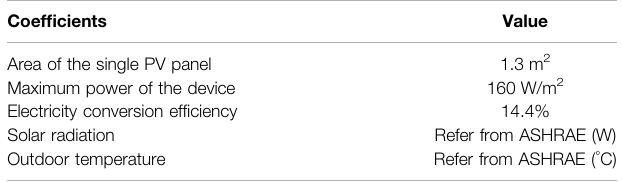
TABLE 2 | Speci fi cations of the detached house